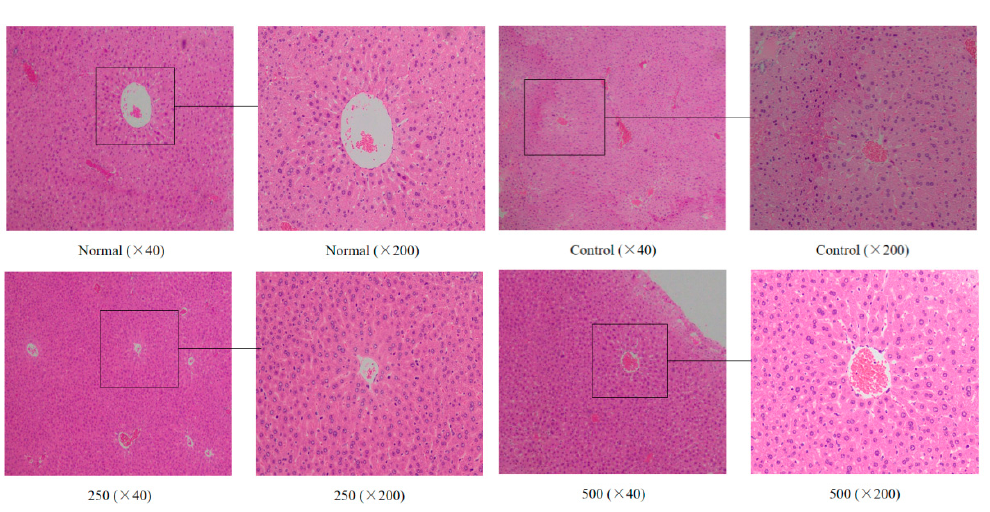
Figure 1. Effect of AVTE on the hepatic tissue morphology in the mice injured by D -galactose. Normal: Normal group; Control: Model control group induced by D -galactose, 120 mg/ (kg·d); 250: Low dose group, 250 mg/kg; 500: High dose group, 500 mg/kg.